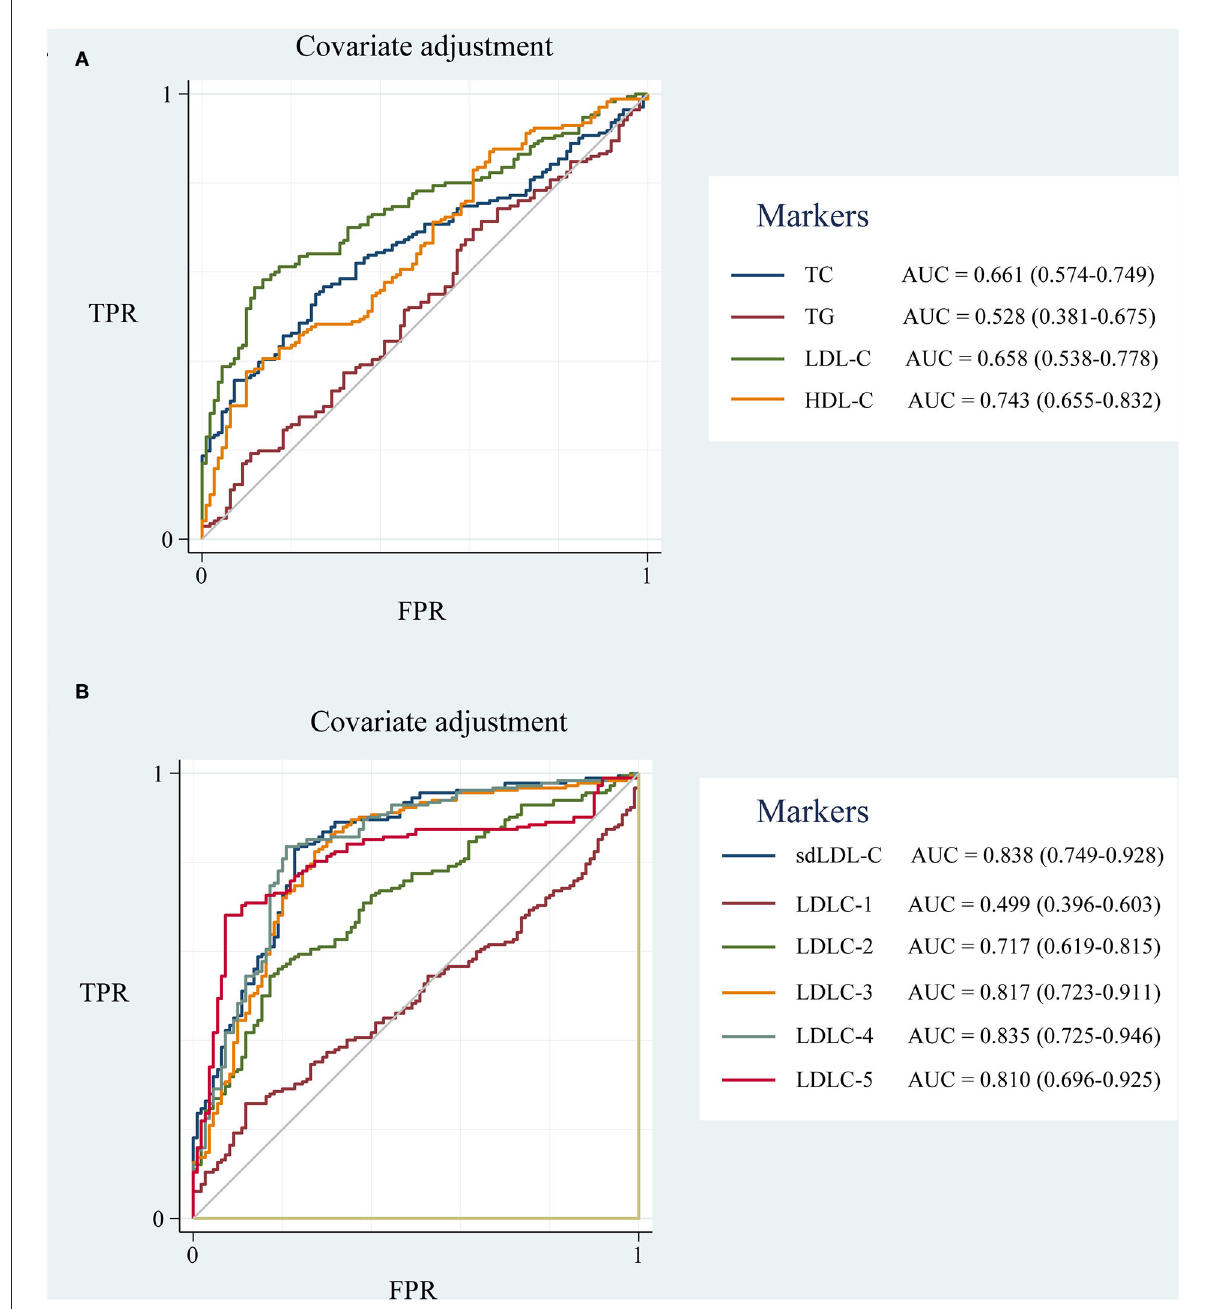
FIGURE5 The ROC curve of blood lipids adjusted for covariates of age, gender, hypertension and diabetes disease history, drinking and smoking history. (A) TC, TG, HDL-C, and LDL-C; (B) LDL-C subfractions (LDLC-1 to LDLC-7) and sdLDL-C. ROC curve, receiver operator characteristic curve; AUC, area under the curve; TC, total cholesterol; TG, triglyceride; HDL-C, high-density lipoprotein cholesterol; LDL-C, low-density lipoprotein cholesterol; sdLDL-C, small dense low-density lipoprotein cholesterol; TPR, true positive rate; FPR, false positive rate.